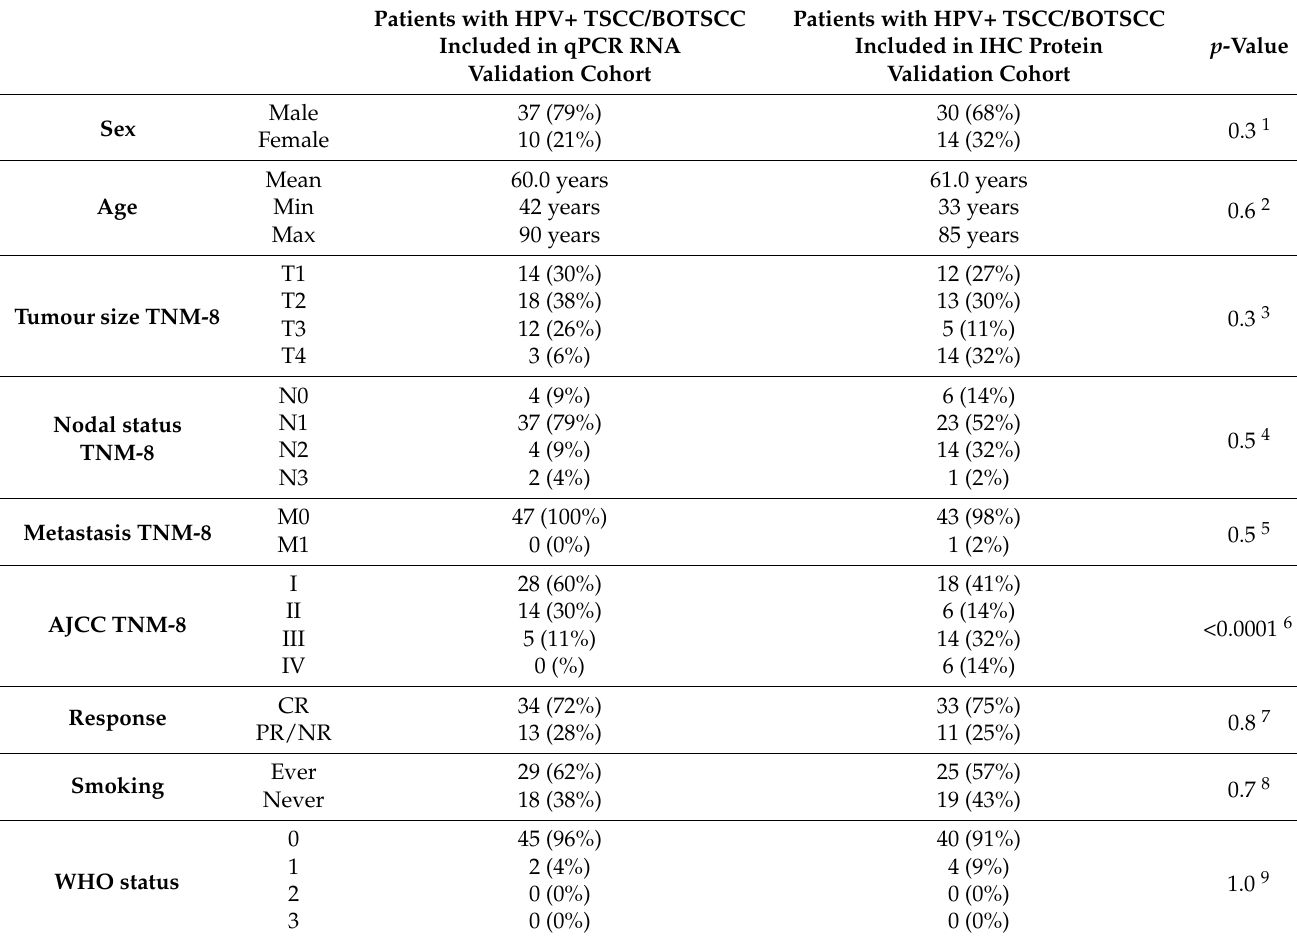
Table 2. Patients included in the validation cohorts and their tumour characteristics. Patients with HPV+